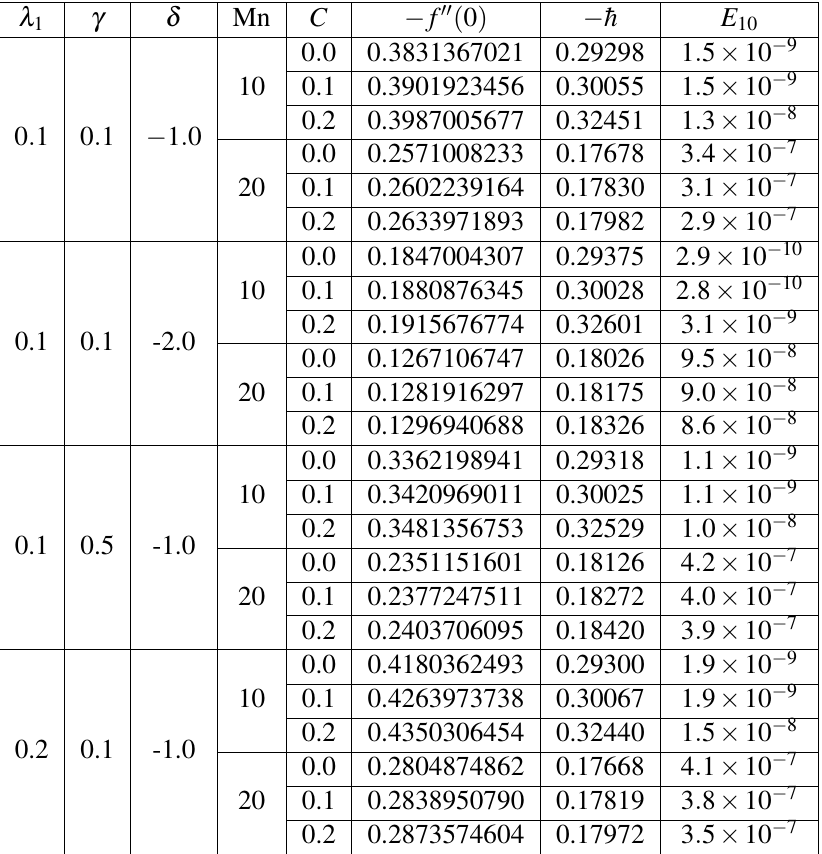
Table 2 Values of dimensionless skin friction coefficient − f (cid:48)(cid:48) ( 0 ) for different values of Mn, C , λ 1 , γ , and δ